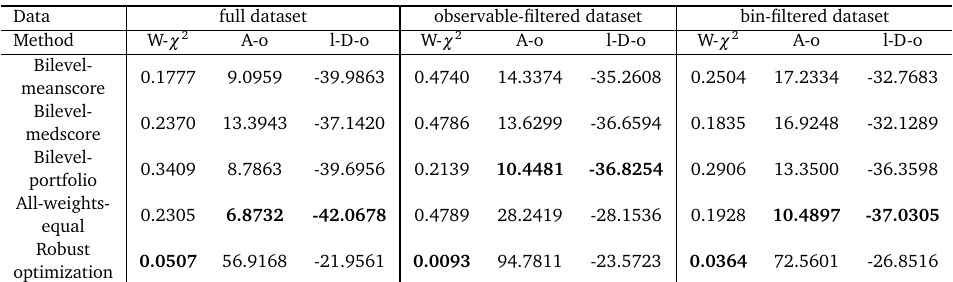
Table 30: Results for the comparison metrics for the full, observable-filtered and bin- filtered S HERPA dataset using the cubic polynomial approximation, calculated on the full dataset. The best results are in bold. In each dataset, W- χ 2 refers to the Weighted χ 2 metric, A-o refers to the A-opt metric, and l-D-o refers to the log D-opt metric. Note that we do not have an expert solution for this